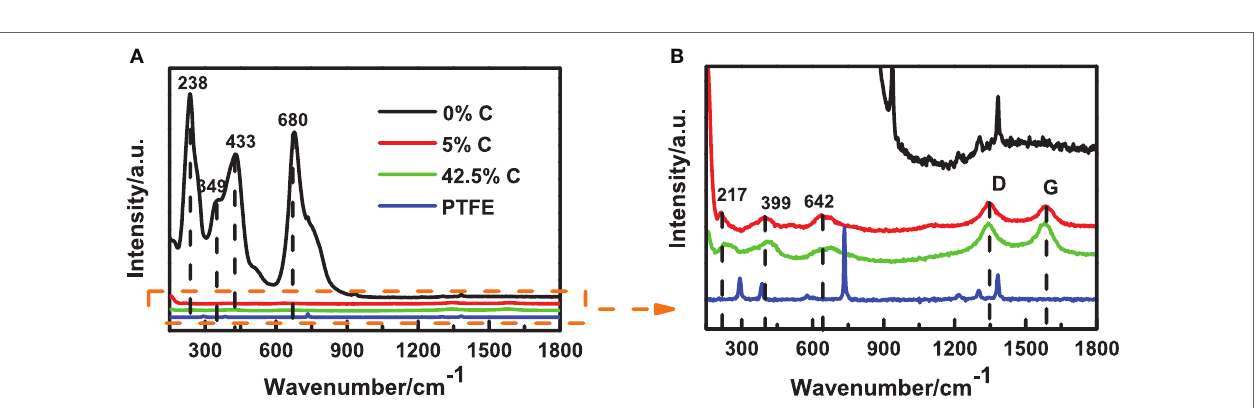
FigUre 6 | Raman spectra of Li 4 Ti 5 O 12 electrodes with different carbon contents. (a) Raman spectra of three Li 4 Ti 5 O 12 electrodes and (B) enlarged view of (a)